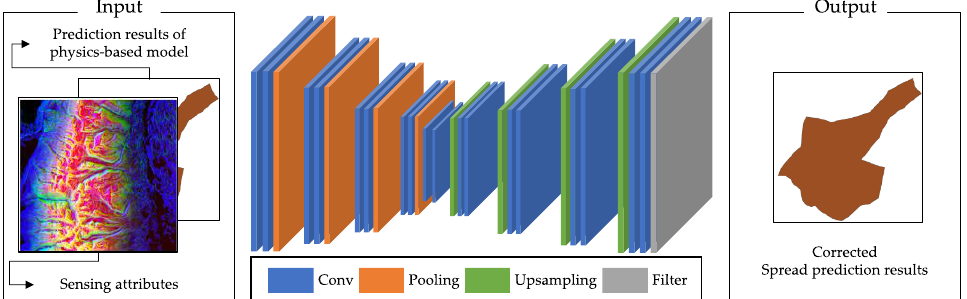
Figure 6. The network structure of the CNN-based model for the data-driven error correction FE.